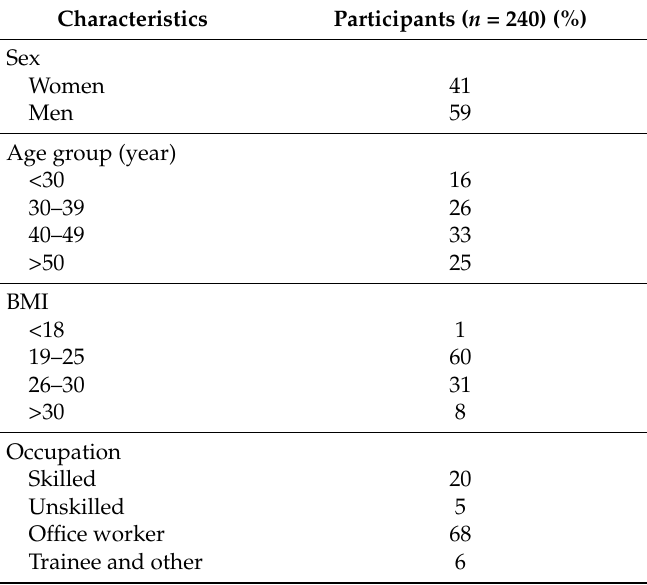
Table 2. Characteristics of